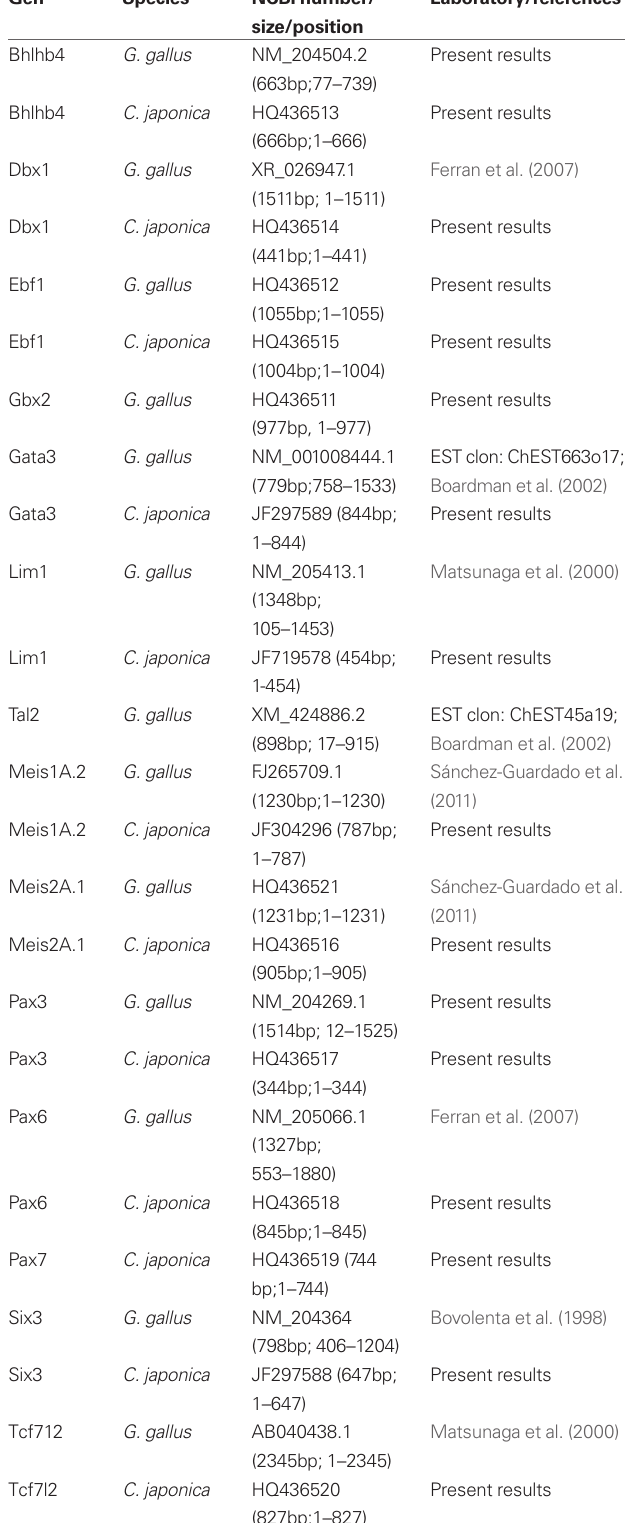
Table 1 | List of gene markers used, sequence of the gene in the construct, and origin of the plasmid